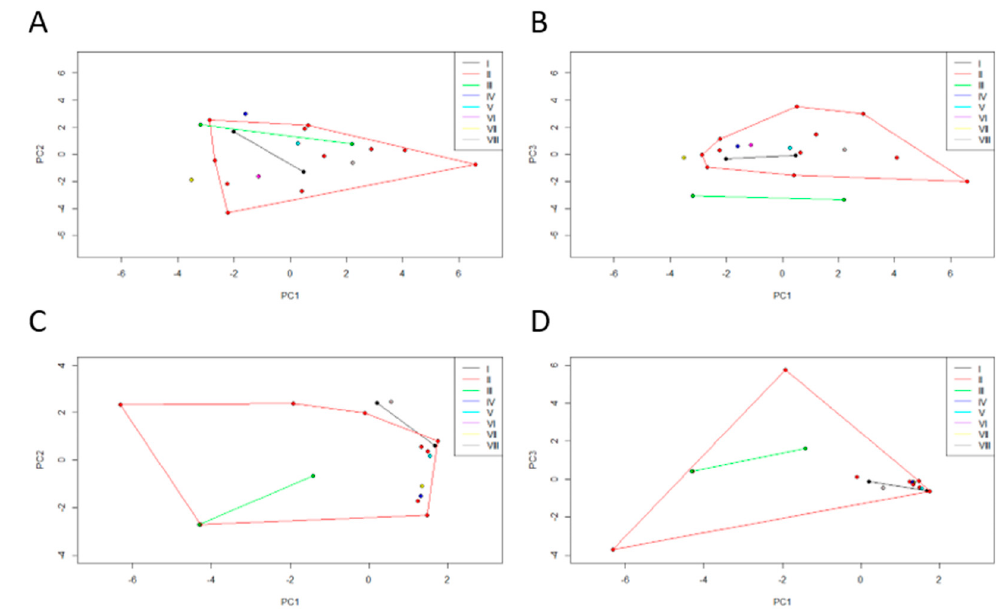
Figure 6. Two principal component (PC) plots depicting the dispersal area of ( A , B ) biotic and ( C , D ) abiotic data of each Egyptian mongoose specimen. The 20 specimens are projected in the ( A , C ) PC1 × PC2 and ( B , D ) PC1 × PC3 planes resulting from a principal component analysis performed on the data matrix. The vertices of each polygon correspond to the ( A , B ) biotic and ( C , D ) abiotic data observed for each specimen. Each polygon corresponds to the clusters originated from the microbiota data dendrogram.